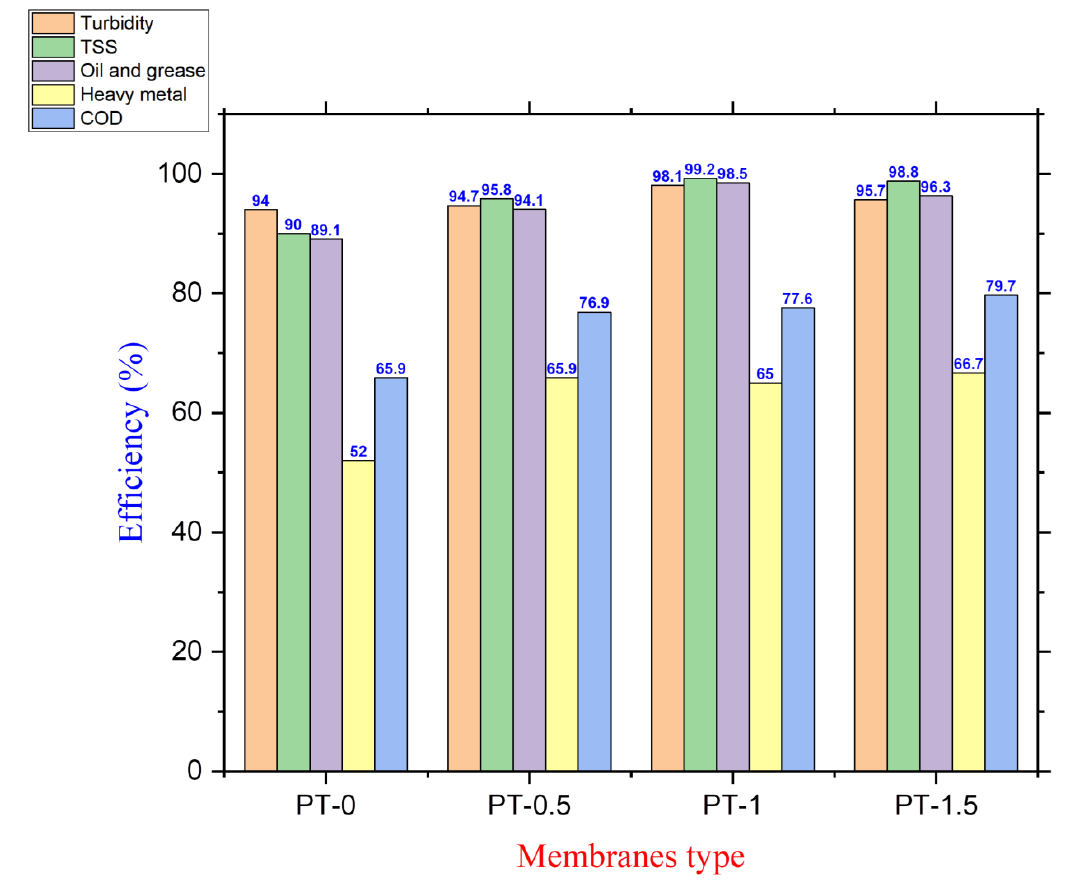
Figure 12. Turbidity, TSS, oil and grease, heavy metal and COD removal efficiency of the PVC membranes at different TiO 2 amounts: (PT-0) 0 gm TiO 2 ; (PT-0.5) 0.5 gm TiO 2 ; (PT-1) 1 gm TiO 2 ; and (PT-1.5) 1.5 gm TiO 2 , by using oily wastewater with characteristics of COD ~290 mg / L; PH ~6.9; TSS ~146 mg / L; and turbidity ~20.7 NTU; heavy metals (Zn = 82.3 µ g / L; Mn = 0); and oil and grease ~40.14 mg / L.